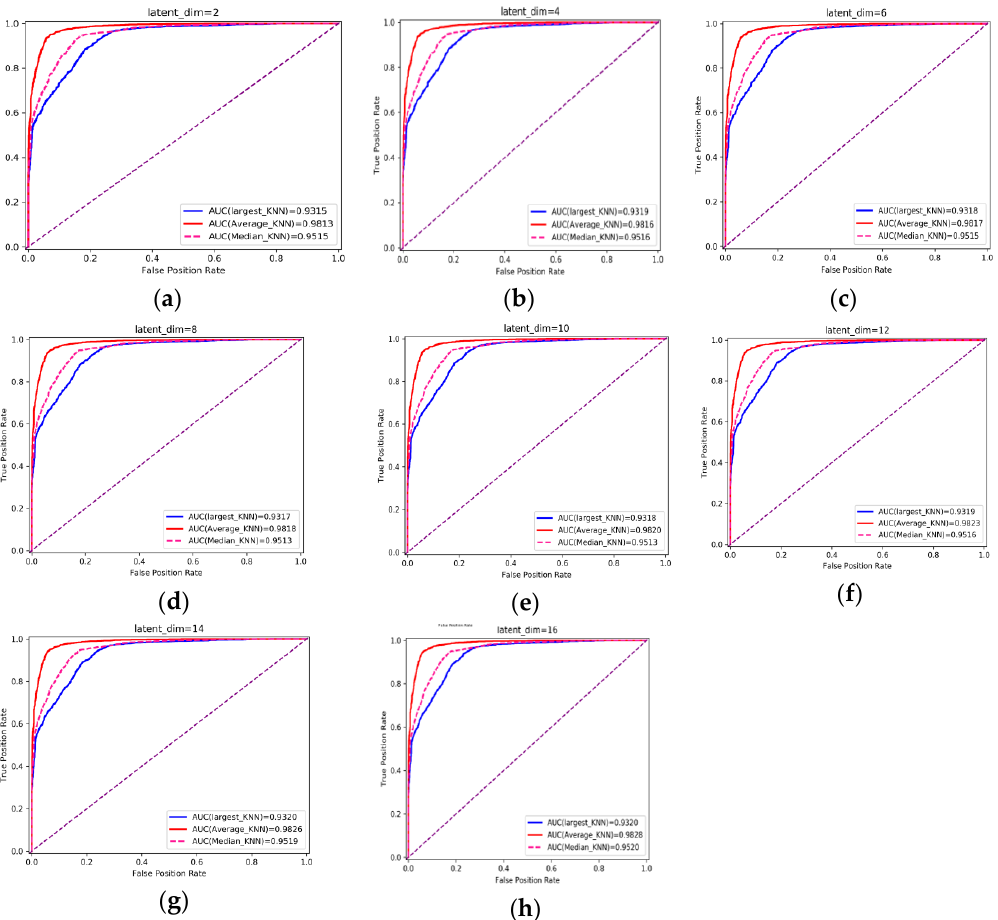
Figure 5. Influence of different latent_dim on detection effect. ( a – h ) correspond to AUC obtained when latent_dim is taken as 2, 4, 6, 8, 10, 12, 14 and 16 respectively.